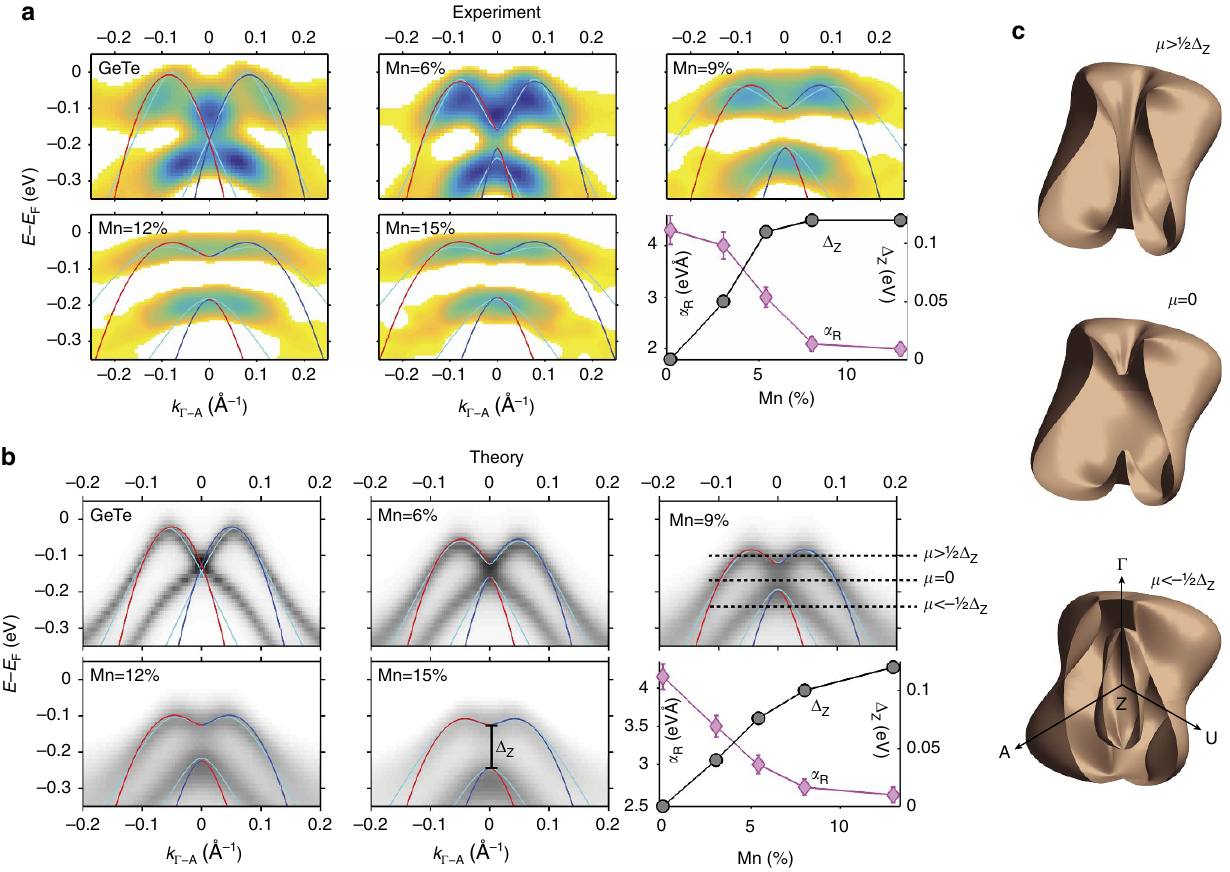
Figure 3 | Rashba–Zeeman (RZ) splitting: experiment, theory and consequences for 3D Fermi surface. ( a ) Zoomed-in ARPES data from Fig. 2f (second-derivative plots from red rectangle area in Fig. 2b) compared with ab initio Ge 1 (cid:2) x Mn x Te calculations for selected Mn dopings in b ; each fitted to a simplified RZ gas model (red/blue lines) and more accurate Dirac fermion model (light-blue lines). The best-fit parameters of the Rashba parameter a R and the Zeeman gap D Z are displayed in the corresponding lower right hand panels. The a R error bars were obtained from varying the fit parameters. ( c ) 3D Fermi surfaces for three different chemical potentials m .